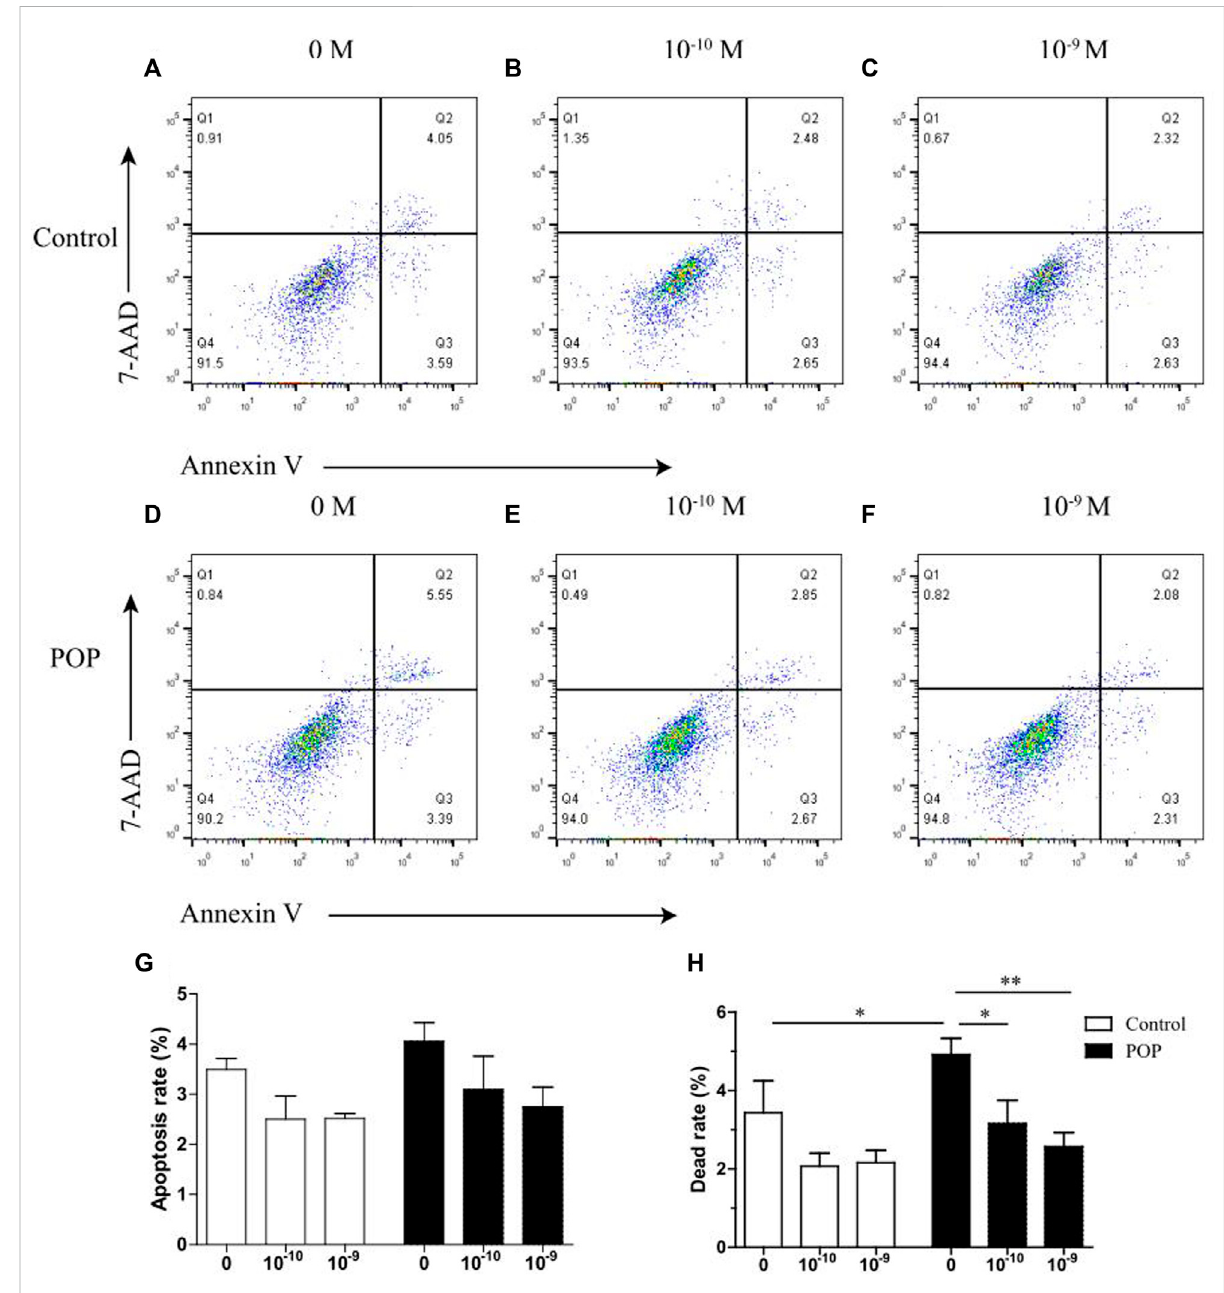
FIGURE 4 Effect of estrogen on mechanical stress induced apoptosis of hUSLFs occurs in a dose-dependent manner. (A) Representative dot plots of cell apoptosis by fl ow cytometry analysis after Annexin V/7-AAD dual staining. The apoptotic rate was determined as the percentage of 7-AAD negative and Annexin V positive (Q3). Cells that are already dead are both Annexin V and 7-AAD positive (Q2). (A,D) 0 M estrogen treatment; (B,E) 10 − 10 M estrogen treatment; (C and F) 10 − 9 M estrogen treatment. (G) Quanti fi ed apoptotic rates of hUSLFs treated with various concentrations